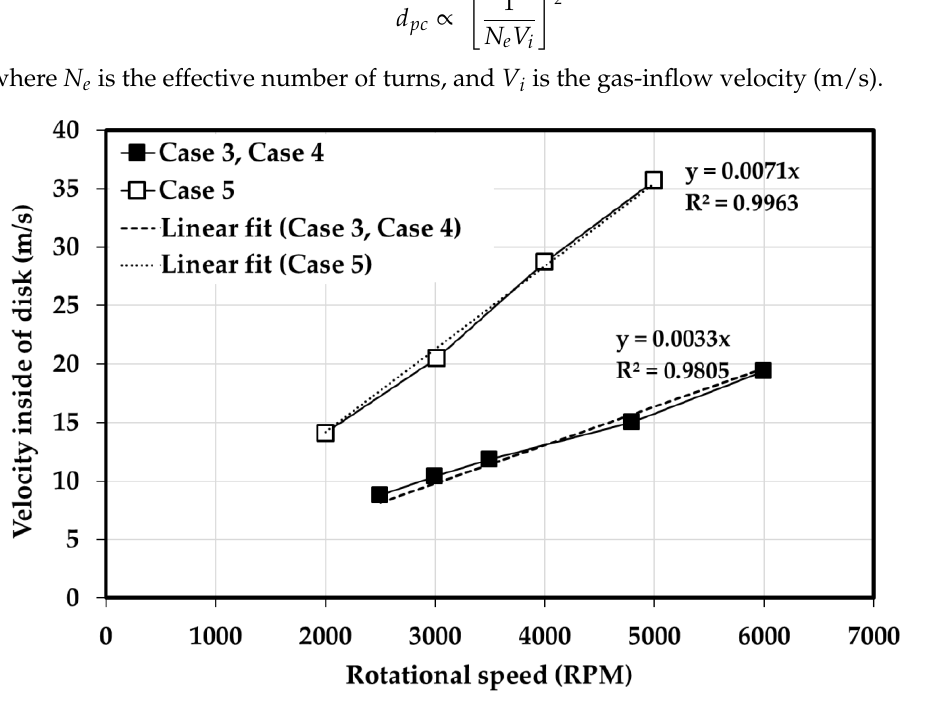
Figure 7. Flow velocities inside the disk according to the rpm.